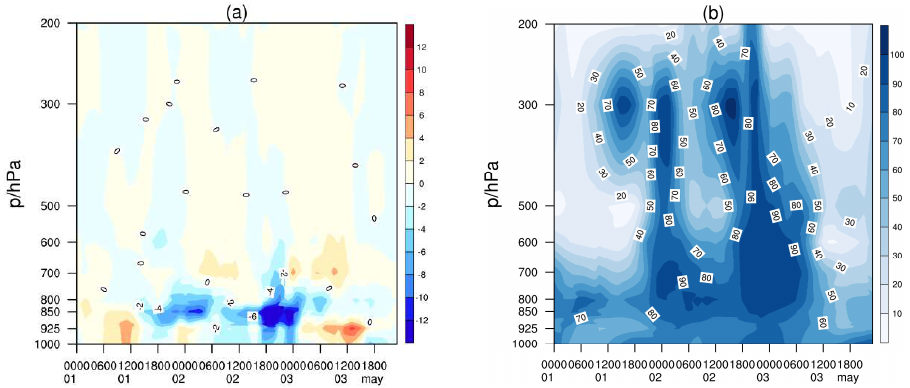
Figure 5. Height–time profile of ( a )area-averaged moisture flux divergence, 10 −5 g·s −1 ·hPa −1 ·cm −2 and ( b ) relative humidity, %, over the rainstorm area (30.25° N–31.55° N, 106.05° E–108.05° E).